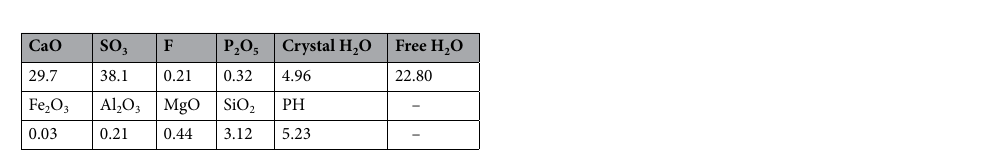
Table 3. Chemical composition of phosphogypsum